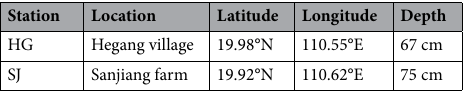
Table 3. Core stations and